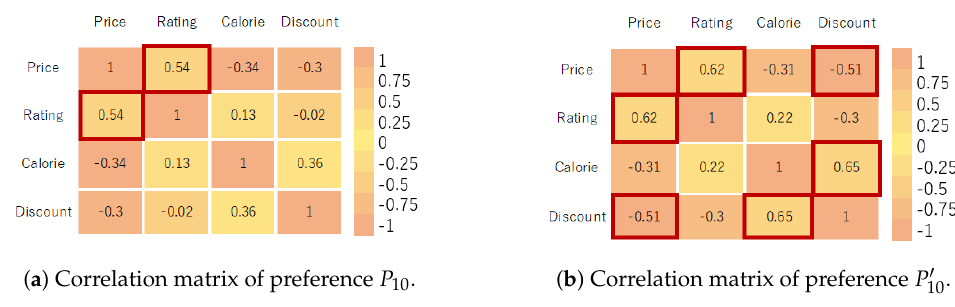
Figure 7. Heat map of correlation matrix before and after applying Procedure 1.